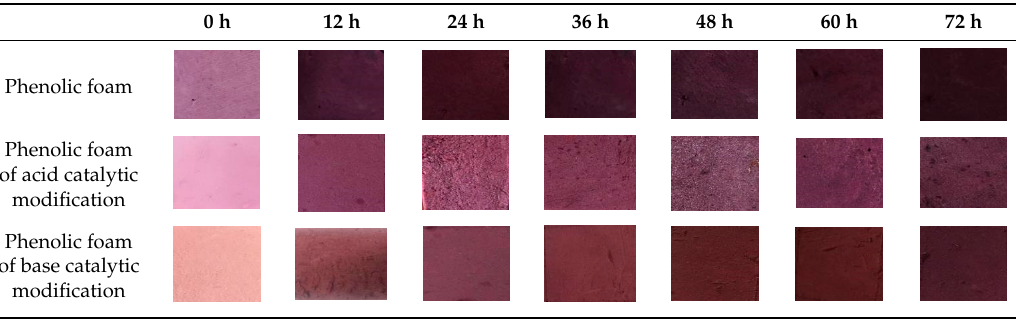
Table 4. Schematic diagram of heat aging color change of modified phenolic